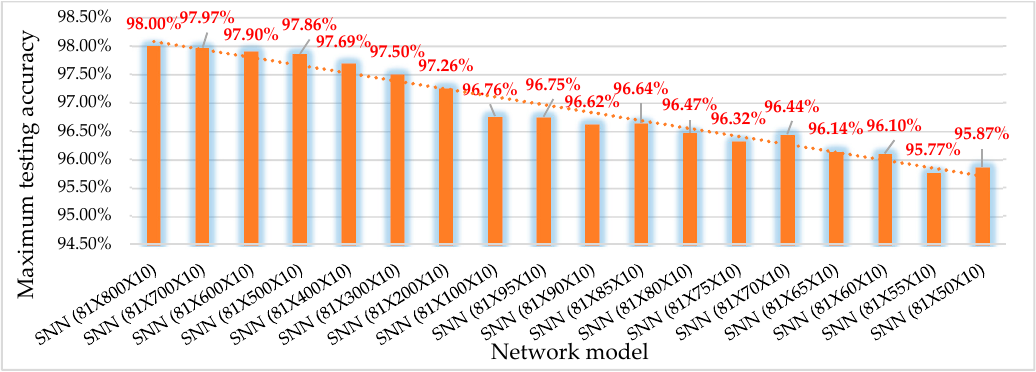
Figure 5. Maximum testing accuracy of SNNs with one hidden layer of (800 to 50) neurons.